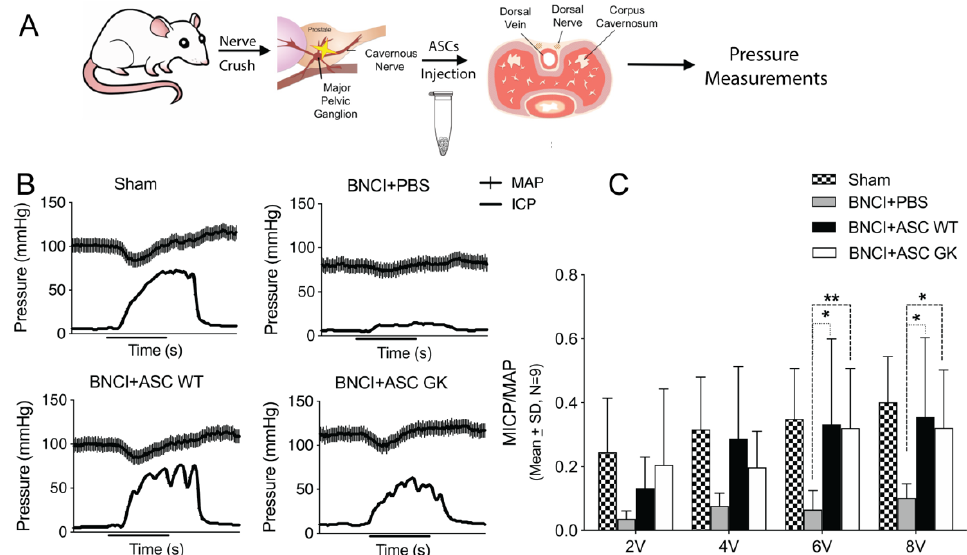
Figure 3. Assessment of erectile function following ASC WT or ASC GK treatment. ( A ) Schematic representation of the in vivo experiment. Rats were subjected to bilateral nerve crush injury (BNCI) followed by penile injection of vehicle (PBS) or ASC WT or ASC GK and compared with sham controls (n = 9 in each group). 28 days after surgery the erectile function was evaluated by intracavernosal pressure (ICP) (mmHg) recordings during electro-stimulation of 2, 4, 6 or 8V. ( B ) Representative ICP and mean arterial pressure (MAP, mmHg) traces in response to 8V electro-stimulation for 50 sec (marked by a line below the x -axis) in Sham, BNCI+vehicle, BNCI+ASC WT and BNCI+ASC GK treated rats are shown. ( C ) The maximum ICP increase (MICP) was normalized to MAP by calculating the MICP/MAP ratio in order to compare erectile function between animals. Data are represented as mean ± SD, and statistical significance was tested by mixed-effect model (REML) with Tukey ’ s multiple comparison test. * p < 0.05, ** p < 0.01.